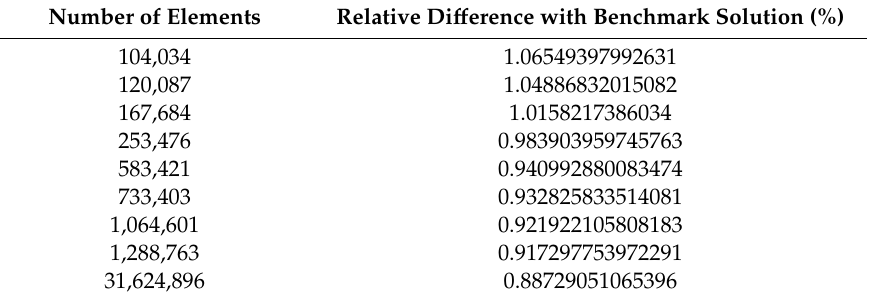
Table 2. Relative difference with benchmark solution for nine different numbers of meshes. Number of Elements